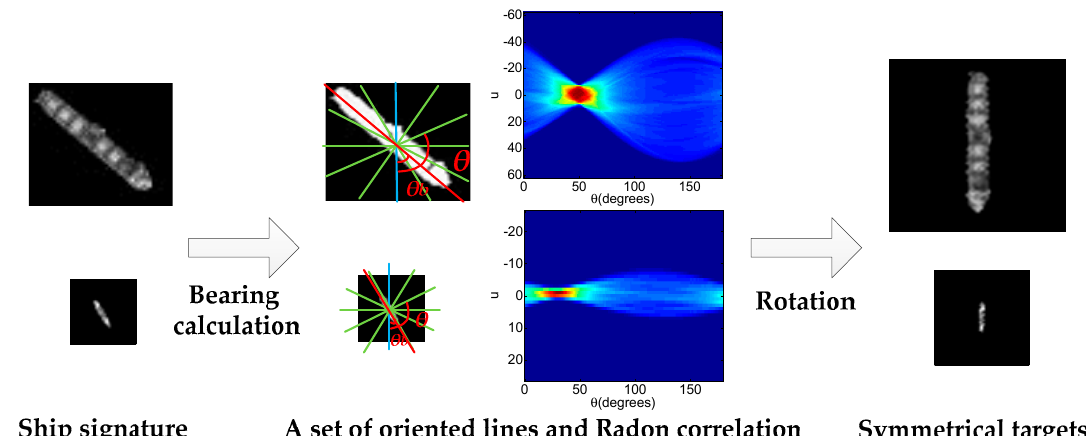
Figure 9. Rotation and alignment: (from left to right) target chips after fine segmentation, description of θ and θ b , Radon transform, results of the transform.